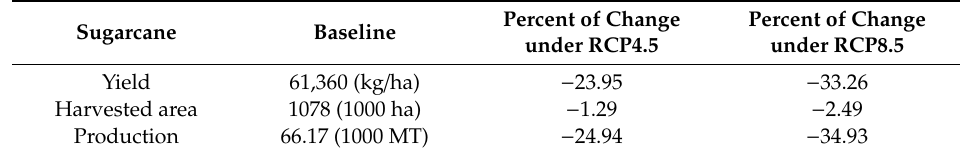
Table 4. National projected changes in yield, harvested area, and production of sugarcane under RCPs 4.5 and 8.5 during 2046–2055 from baseline 1992–2016. Sugarcane Baseline